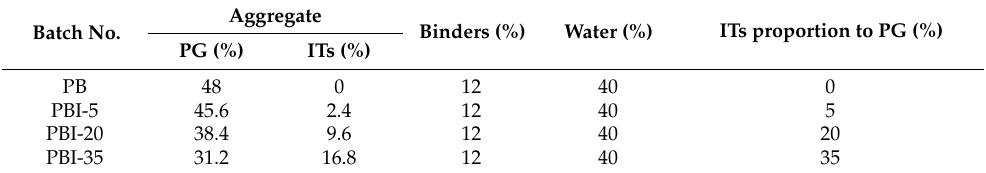
Table 3. Compositions of the cement PG